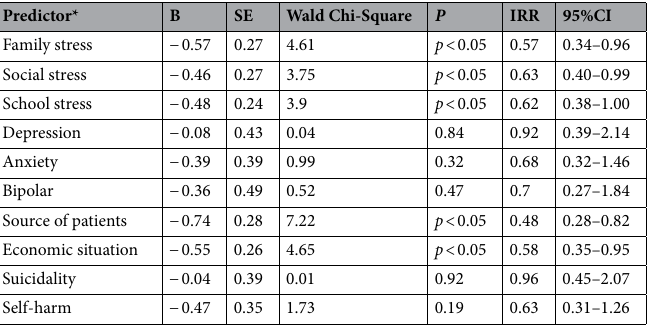
Table 4. Results of the negative binomial regression. *All predictors compare No = 0 versus Yes = 1 except Economic situation and Source of patients where General = 0 and Better = 1, outpatient = 0 and ward = 1. B, regression coefficient; SE, standard error; P , p -value; IRR, rate ratio; CI, confidence